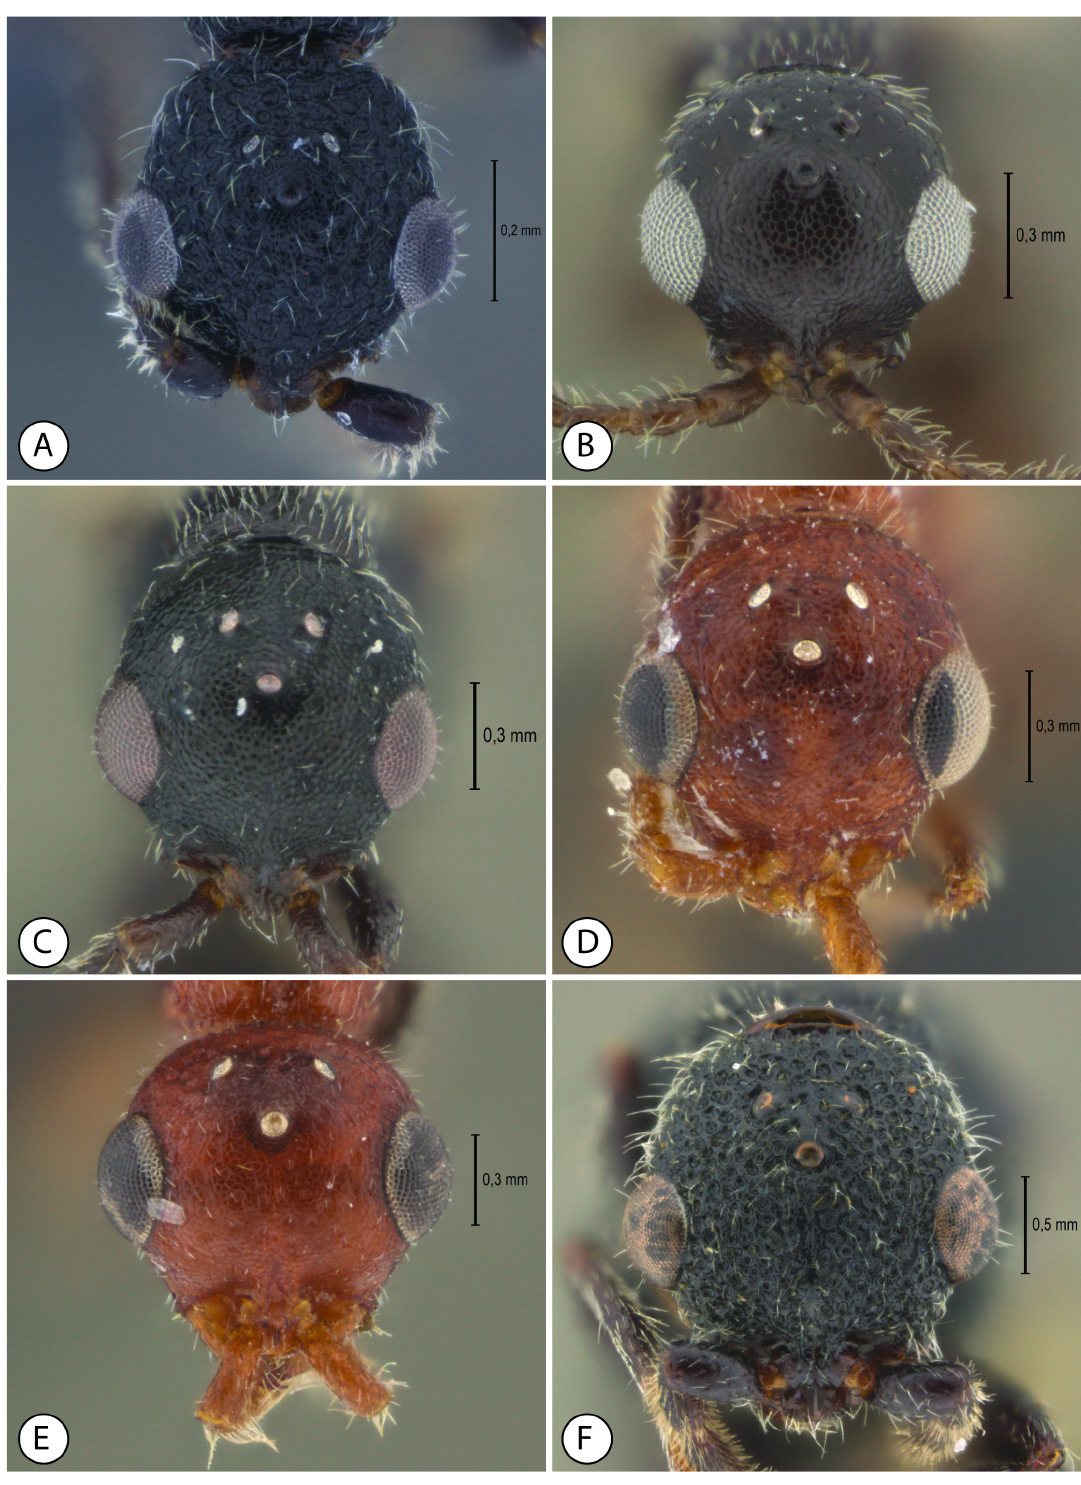
Fig. 4. Head of Astromesitius gen. nov., dorsal view. A . A. olavoi gen. et sp. nov. (holotype, QBG) B . A. thionyi gen. et sp. nov. (holotype, UFES 118956) C . A. carbonarius (Móczár, 1970) gen. et comb. nov. (UFES 56168) D . A. indistintus (Barbosa & Azevedo, 2011) gen. et comb. nov. (paratype, UFES) E . A. minutissimus (Móczár, 1971) gen. et comb. nov. (holotype, UFES 56528) F . A. quatei (Móczár, 1977) gen. et comb. nov. (holotype,